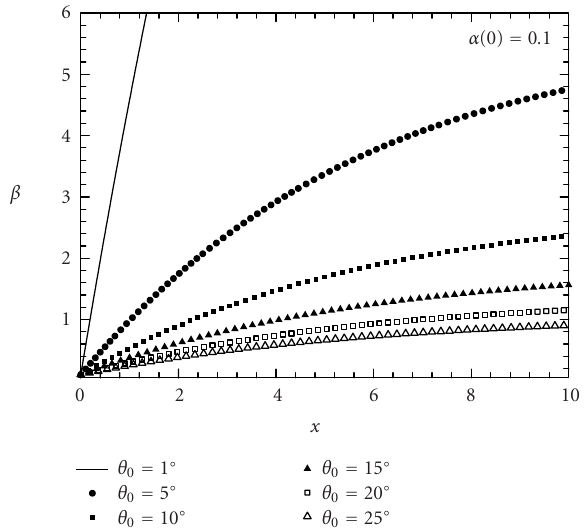
Figure 8: The vertical distorted velocity coe ffi cient β propagates along axial direction at smaller inlet incident angles, θ 0 ≤ 25 ◦